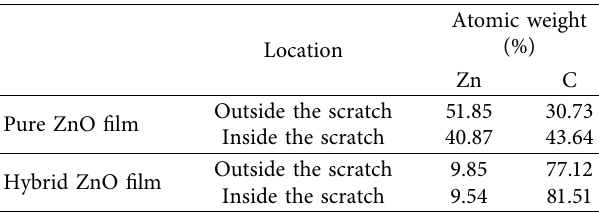
Figure 7: (a) Hardness, (b) elastic modulus, and (c) H/E ratio of pure ZnO and hybrid flms are shown. Table 2: Atomic weight ratios in and outside of scratch tracks for pure and hybrid ZnO